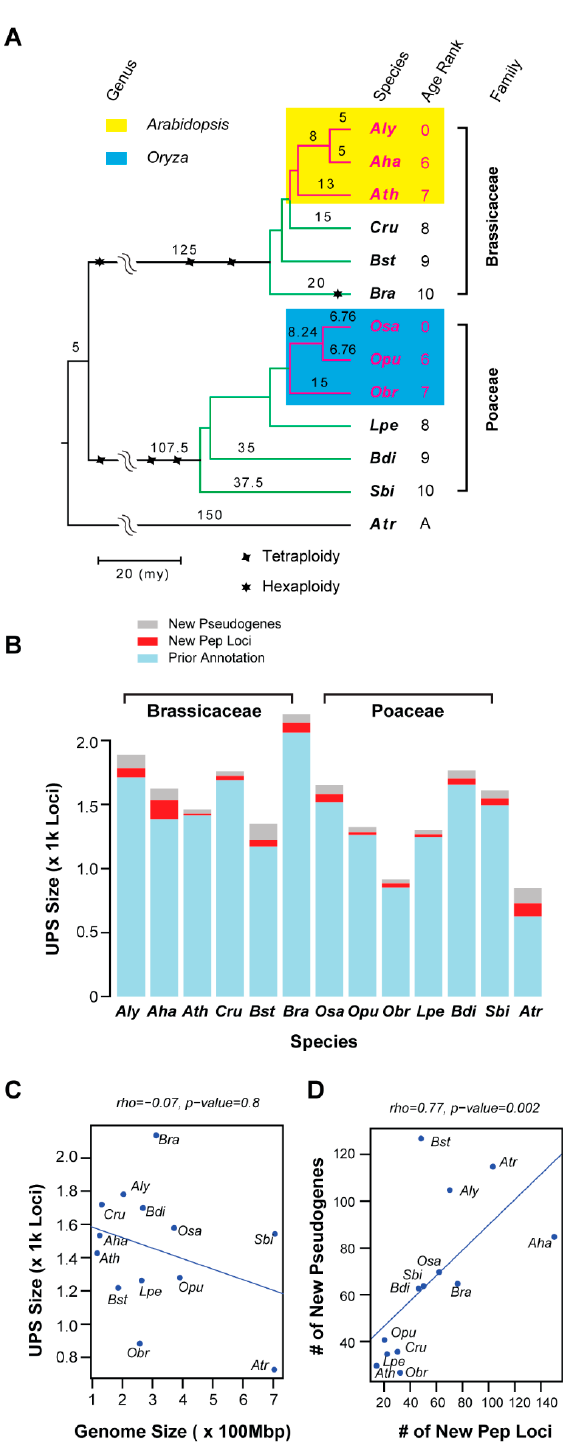
Figure 1. Annotation of the UPS members in Brassicaceae and Poaceae. ( A ) Phylogenetic relationship of 13 selected species. The tree topology and whole genome duplication events were inferred from literature [29,35]. The age rank is assigned for ordering purpose based on the split time of each species as defined in literature [29]. Species abbreviations in this panel and others are described in Table S2. ( B ) Comparison of the UPS sizes across 13 plant species. ( C ) No correlation is present between the genome size and the UPS size in the 13 plant genomes analyzed. Mbp: million base pair. ( D ) A significant correlation is present between the number of new pseudogenes with the number of new peptide loci in the UPS group of the 13 plant